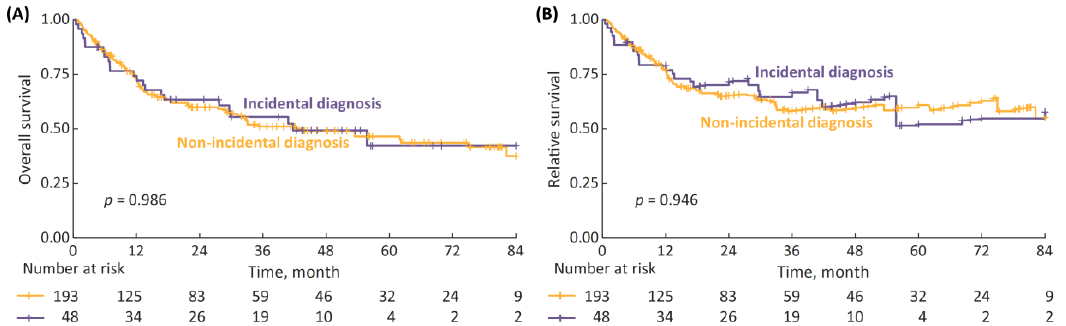
Figure 4. (A) 7-year overall survival (OS) in high-grade (HG) patients stratified by type of diagnosis (incidental vs. non-incidental); and (B) 7-year RS. The 7-year OS and RS analyses for non-metastatic HG NMIBC patients stratified by the type of diagnosis demonstrated a modest, non-significant trend toward inferior sur- vival with incidental diagnosis ( p = 0.172 for OS and p = 0.228 for RS, Figure 5 A-B). The analyses performed for non-metastatic MIBC patients, with the follow-up limited to 3 years in view of a small numbers of patients at risk, revealed that the survival of inci- dentally diagnosed cases may have been superior (Figure 5 C-D), with 3-year OS and RS for incidental vs. non-incidental diagnosis being 71% vs. 21% ( p = 0.053) and 97% vs. 23% ( p < 0.001), respectively. Figure 5. (A) 7-year overall survival (OS) in non-metastatic high-grade (HG) non-muscle-invasive bladder cancer (NMIBC) patients stratified by type of diagnosis (incidental vs. non-incidental); (B) 7-year relative survival (RS); (C) 3-year OS in non-metastatic MIBC patients stratified by type of diagnosis; and (D) 7-year RS. Among the NMIBC patients, the 3-year RFS and PFS for incidental vs. non-incidental diagnosis were 56% vs. 52% and 91% vs. 87%, respectively; however, the differences were not statistically significant (Figure 6).